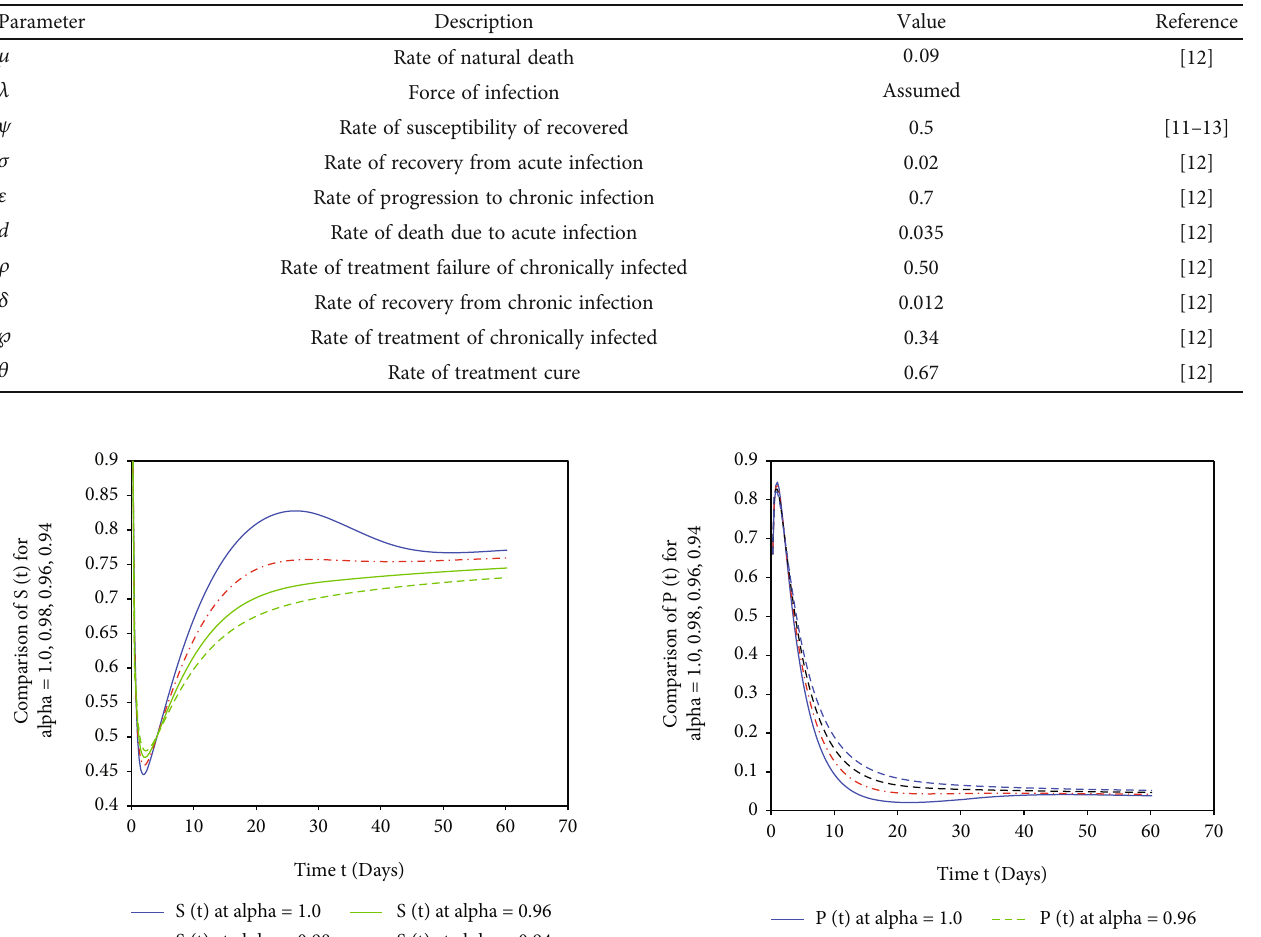
Table 1: Shows the parameter values given in Equation (8). The time units are taken in